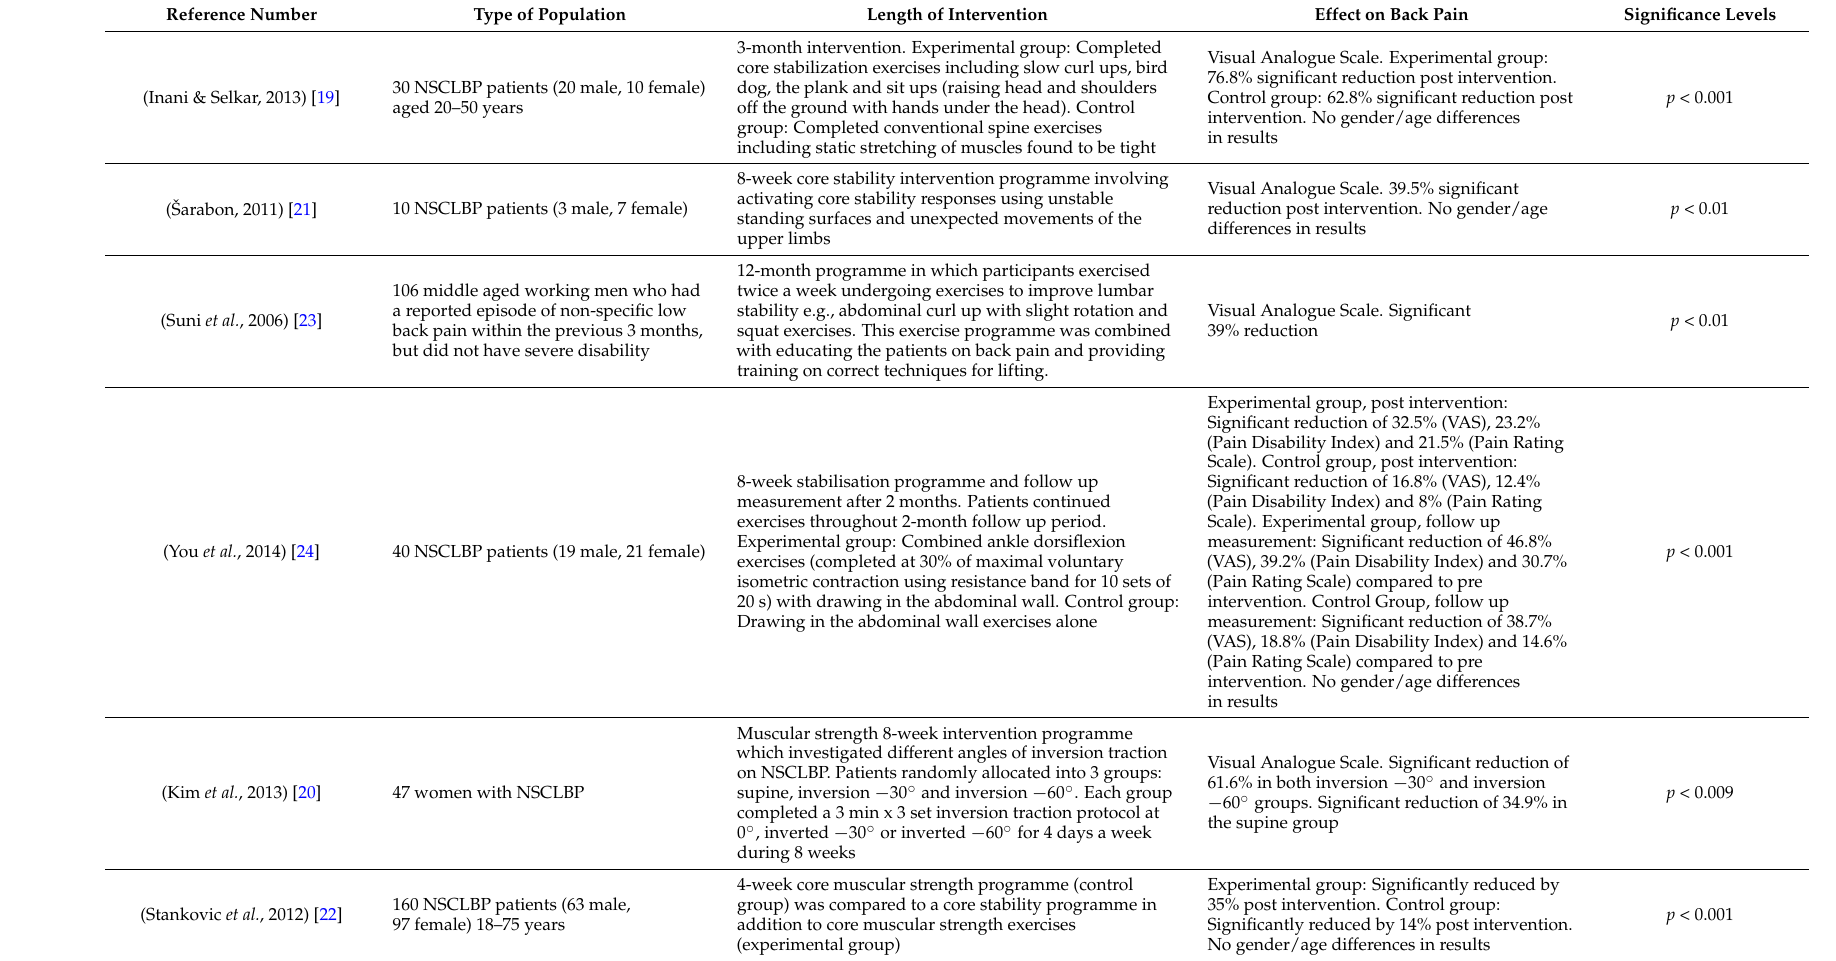
Table 2. Muscular strength and stabilisation intervention programmes for NSCLBP